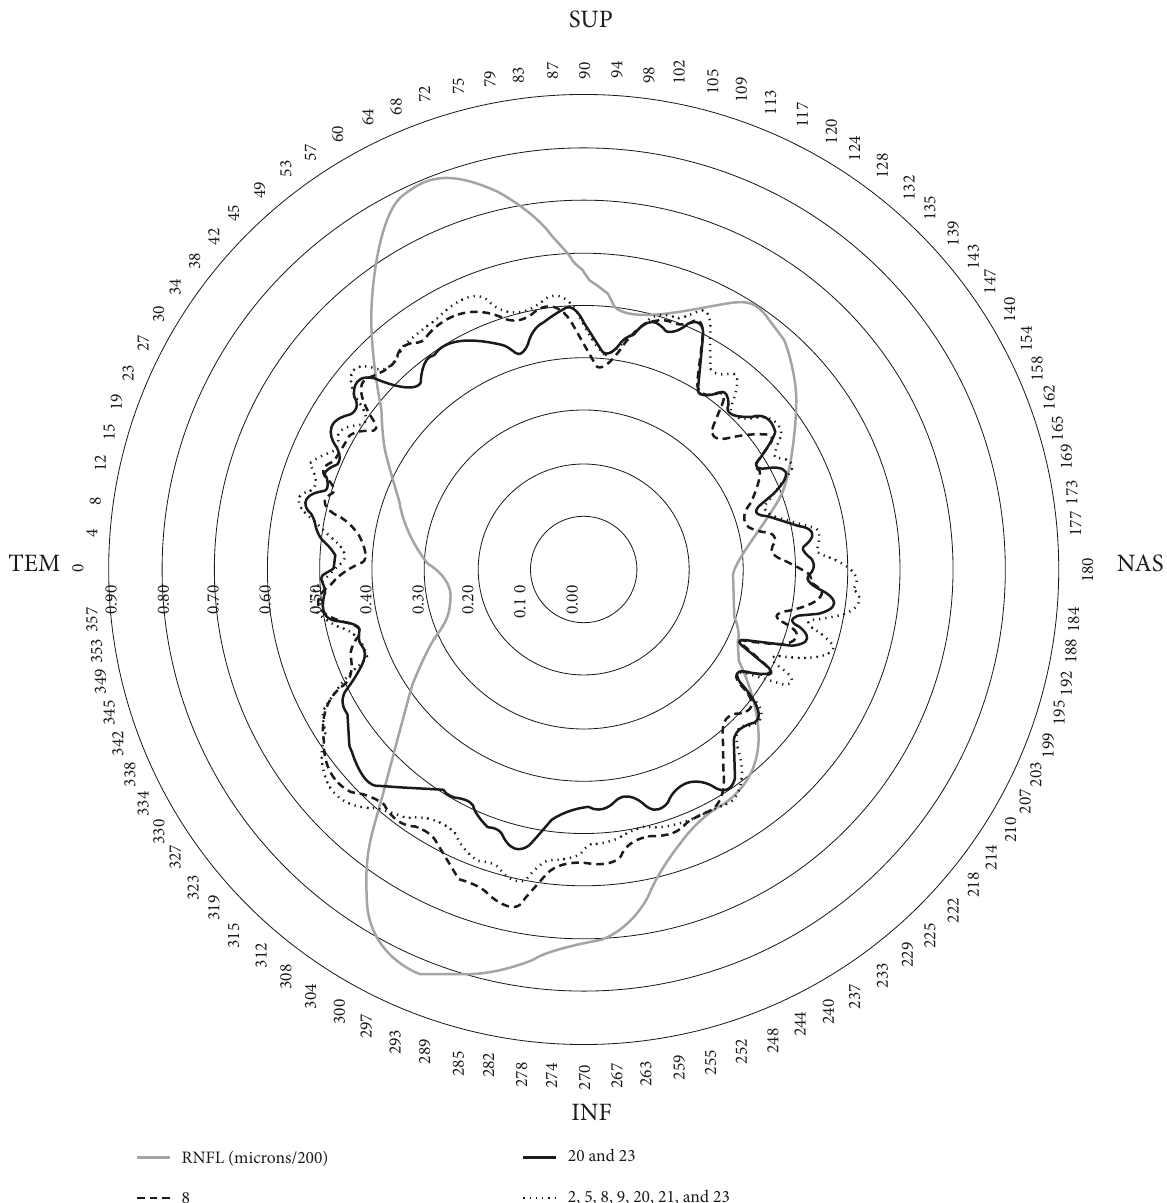
Figure 3: The black lines represent the correlation coe ffi cients of the relative amount of hemoglobin in sector 8 of the optic nerve head, the average in sectors 20 and 23, and the average in sectors 2, 5, 8, 9, 20, 21, and 23, measured by the Laguna ONhE program, with respect to the 768 RNFL thicknesses. The thickness of the RNFL (microns/200) in gray has been superimposed on the